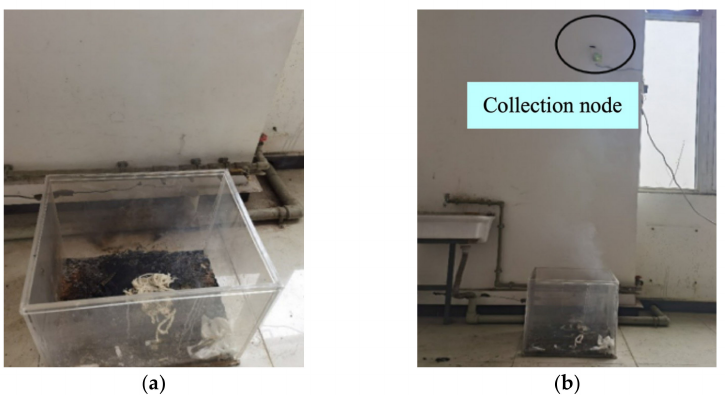
Figure 16. The cotton rope smolder test: ( a ) the process of cotton rope combustion; ( b ) the smol- der